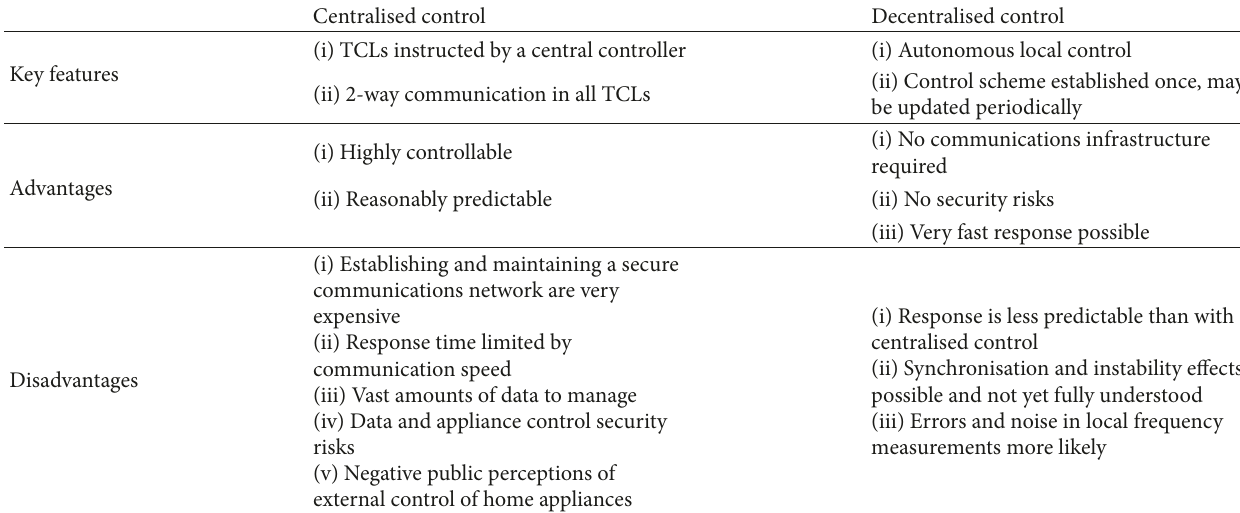
Table 1: Comparison of centralised and decentralised TCL control strategies. Informed by, for example, [19,